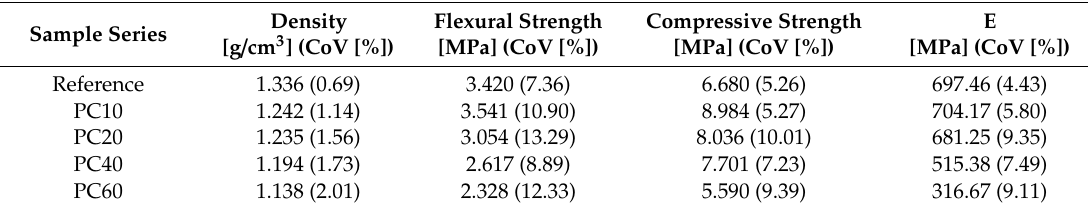
Table 5. Previous test results